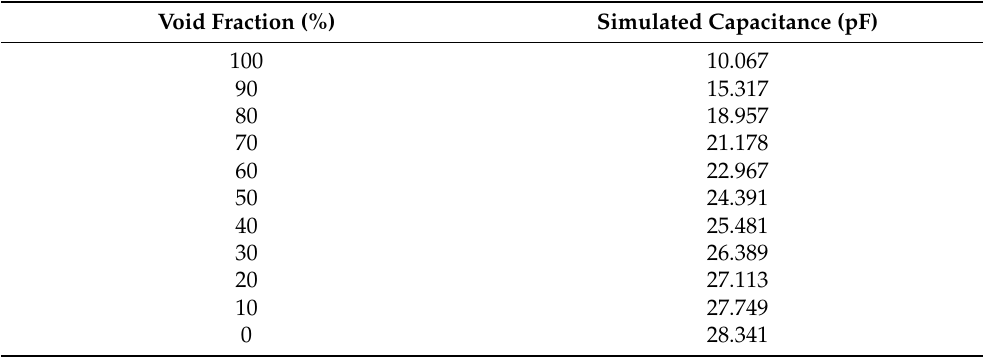
Figure 9. Void fractions from 0 to 100% simulated by COMSOL Multiphysics software. Table 2. Simulation results calculated by COMSOL Multiphysics for the concave sensor in the annular water–air